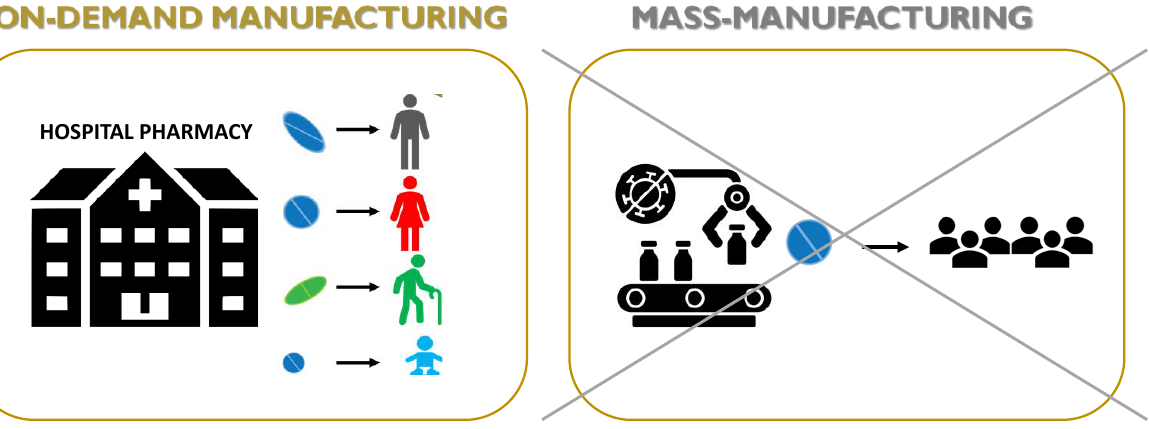
Figure 5. On-demand manufacturing (customized products) vs. mass manufacturing (traditional medicines, one-size-fits-all). The new scenario opened by 3DP technology .